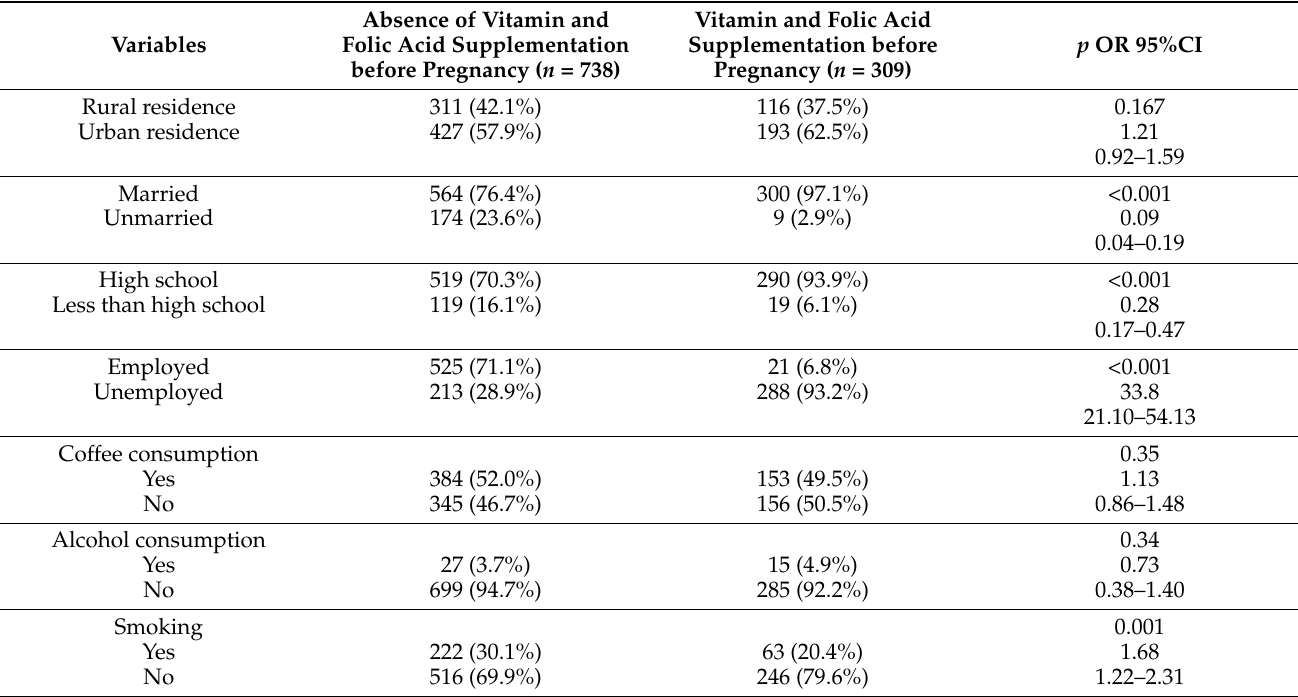
Table 4. Vitamin supplementation pre-pregnancy as related to socio-economic status and behavioral factors with potential risks.